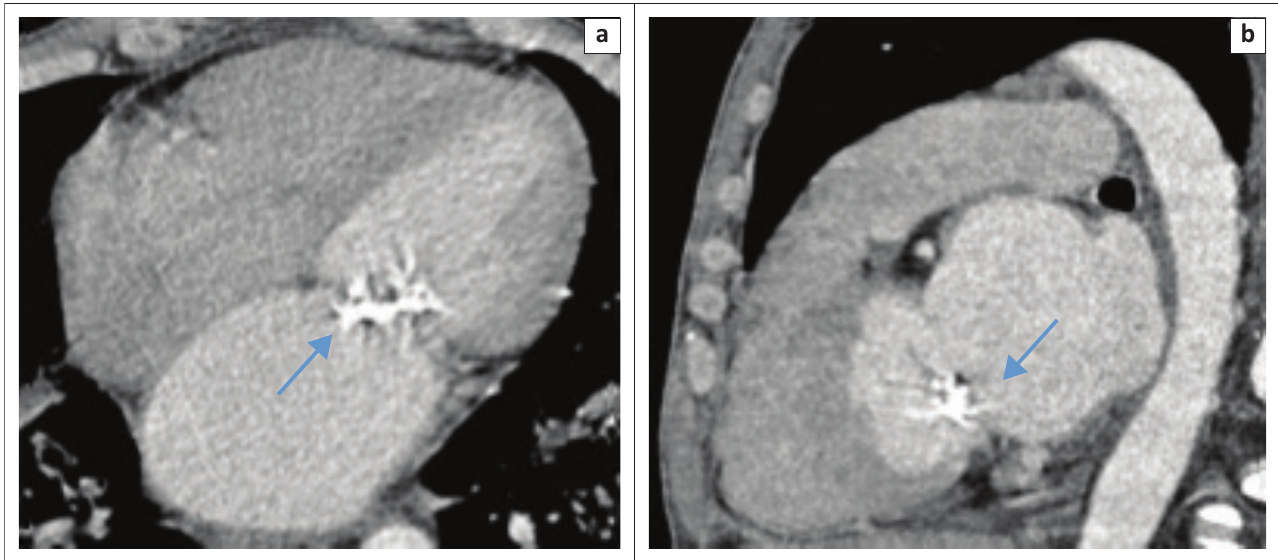
FIGURE 2 : Axial (a) and sagittal (b) contrasted images of the heart demonstrating coarse mitral valve celcifications as indicated by the